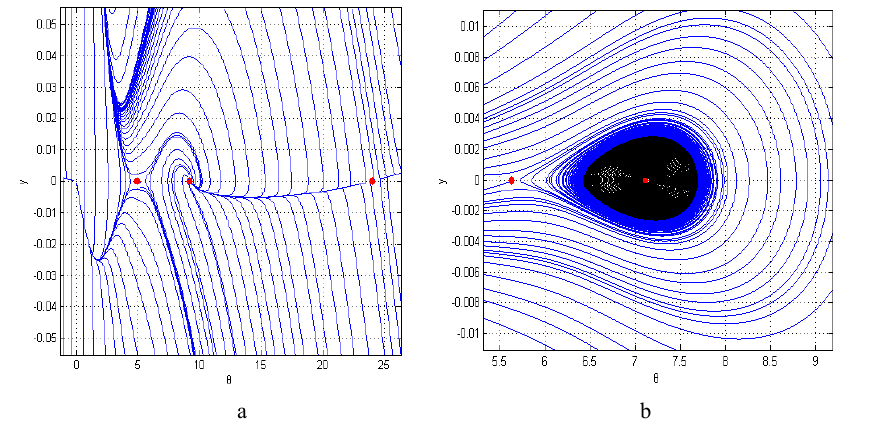
Fig. 1. Phase plane 𝜃  y trajectory diagram, (a).where traveling wave velocity c=-1.26,traveling wave parameter 2.0q *  . (b).where traveling wave velocity c=-1.371,traveling wave parameter